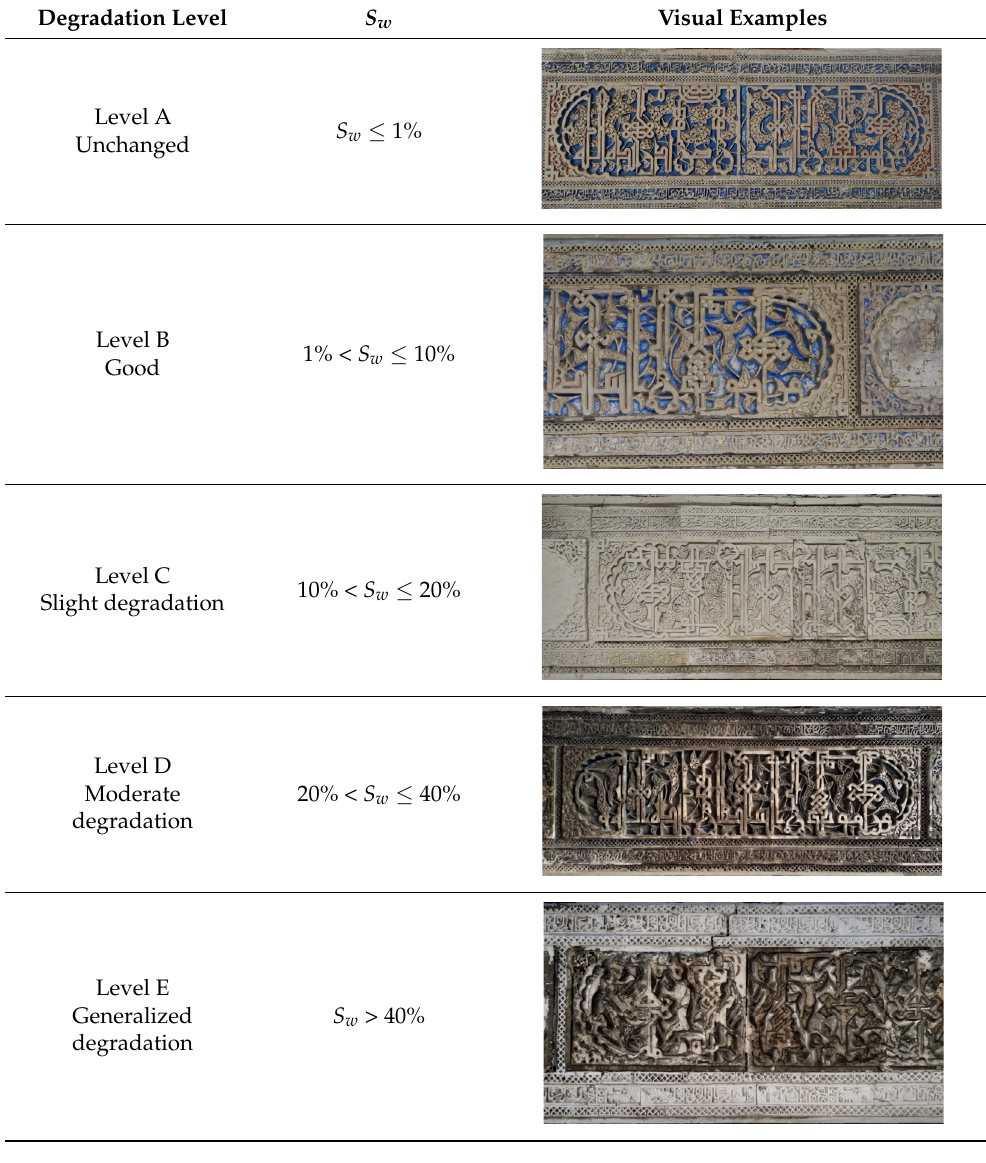
Table 6. Relation between the degradation level and the visual appearance of plasterwork decorations. Degradation Level S w Visual Examples